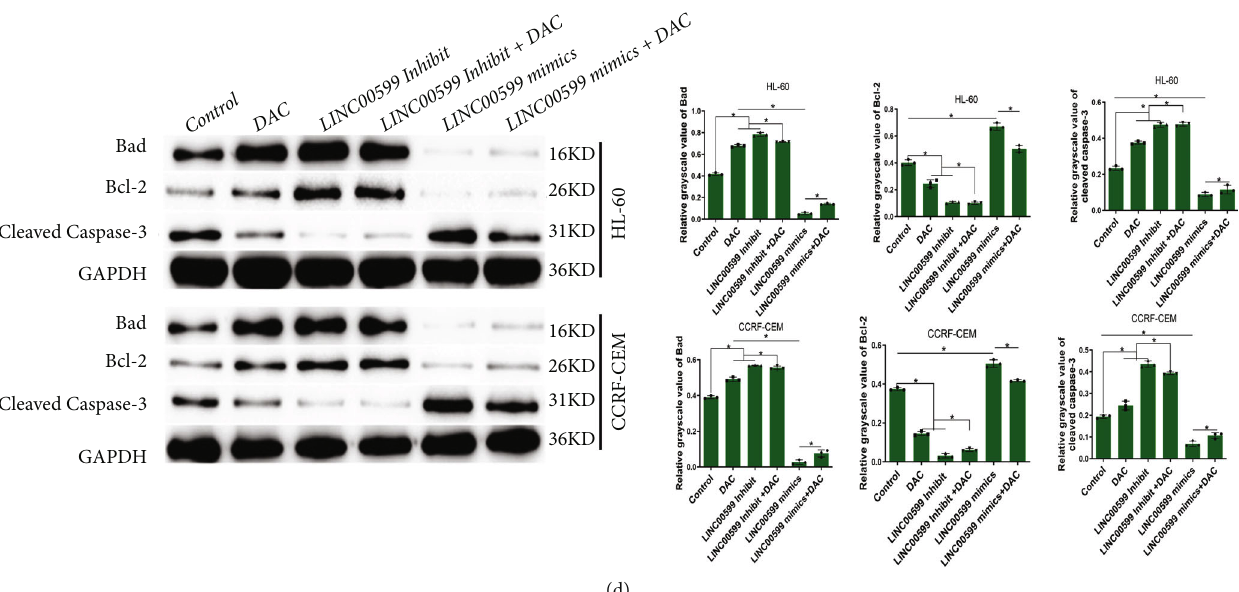
Figure 2: DAC mediated lncRNA expression for apoptosis induction. (a) Results of qPCR analysis examining interference e ffi ciency. (b) Results of CCK8 assay to detect cell proliferation of each group of cells after DAC mediated lncRNA expression. (c) Flow cytometric analysis for the apoptosis of each group of cells. (d) Western blotting results detecting the expression of apoptosis-related proteins in each group of